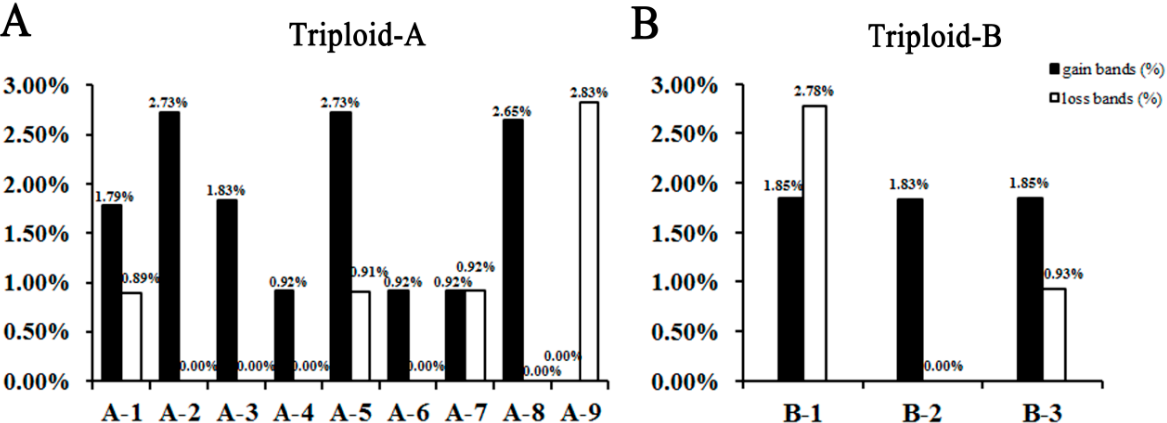
Figure 2. Percentages of “gain bands” and “loss bands” in the Triploid-A lines ( A ) and Triploid-B lines ( B ). A-1, A-2, A-3 . . . A-9 were the triploid hybrids of Triploid-A; B-1, B-2, and B-3 were the triploid hybrids of